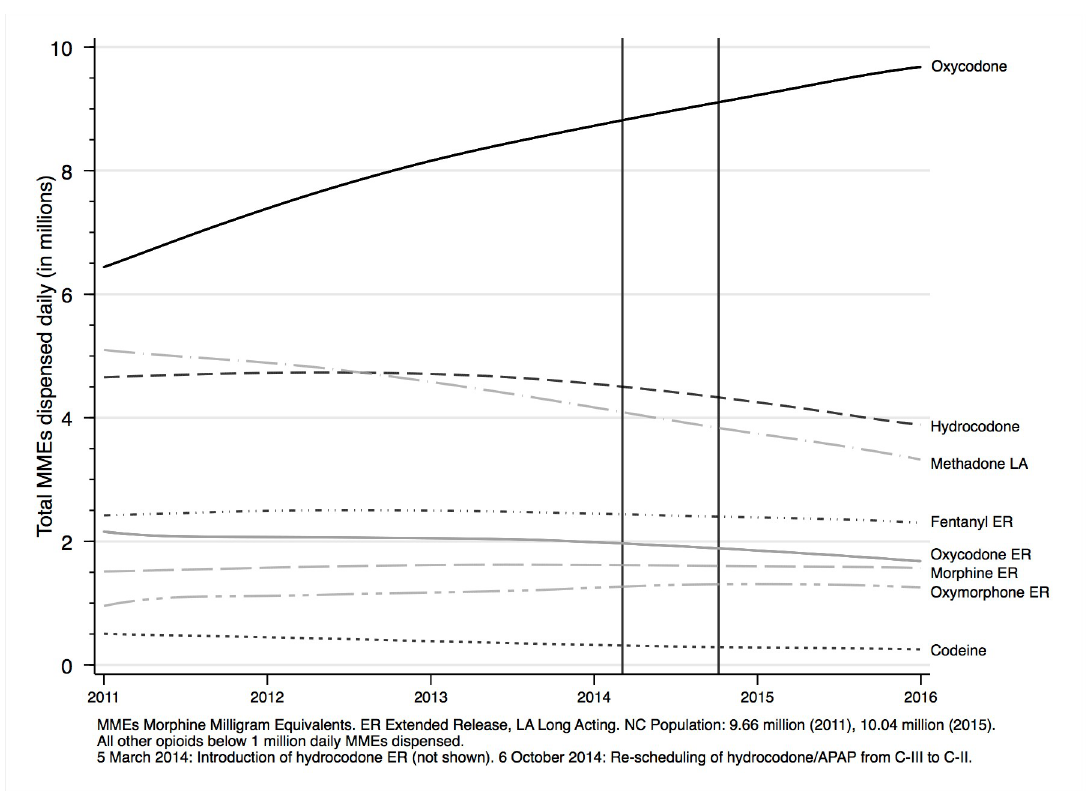
Fig 3. Oral full mu-agonist opioid analgesic and transdermal fentanyl dispensing by active pharmaceutical ingredient, North Carolina, 2011–2015. Notable market regulatory changes to full mu-agonists during the study period included the introduction of hydrocodone extended-release (ER), and the rescheduling of hydrocodone/acetaminophen from a C-III to C-II controlled substance. Hydrocodone ER dispensing was very low and would not be interpretable on the scale of this